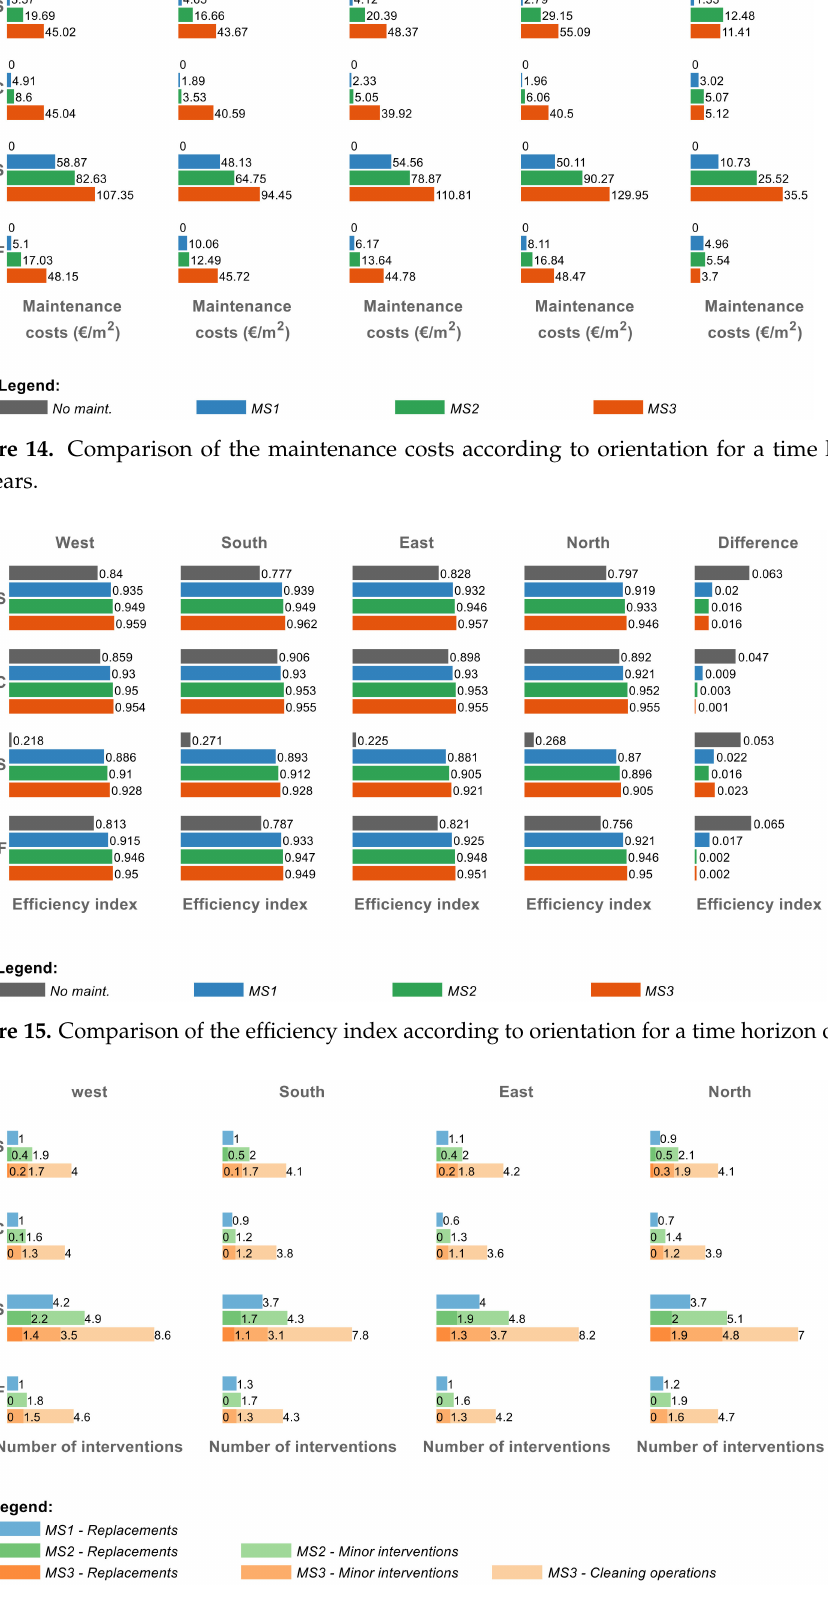
Figure 16. Comparison of the number of interventions according to orientation for a time horizon of 80